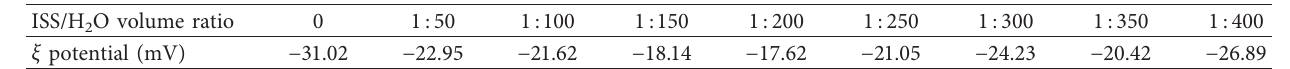
2 O ratios curing for different days. 2 O